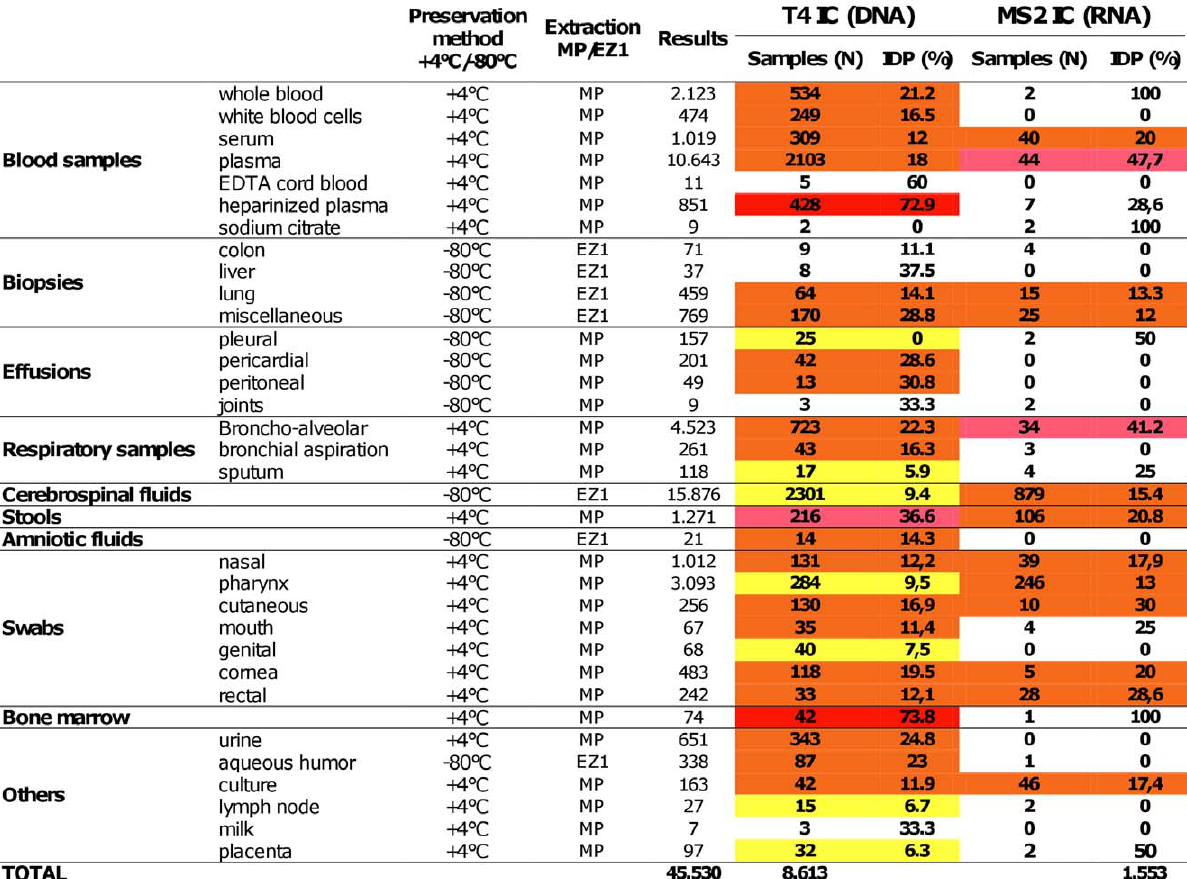
Figure 2. Results of the routine hospital use of bacteriophage ICs. MP (MagNA Pure LC instrument extraction), EZ1 (BioRobot EZ1 extraction). N (Number of samples), IDP (Inefficient detection of the phage). Results represent the number of PCR tests performed for each type of samples. Series with less than 10 samples are no highlighted. Samples with less than 10% of IDPs are highlighted in yellow, between 10 and 30% of IDPs in orange, between 30 and 50% of IDPs in pink and more than 50% of IDPs in red.